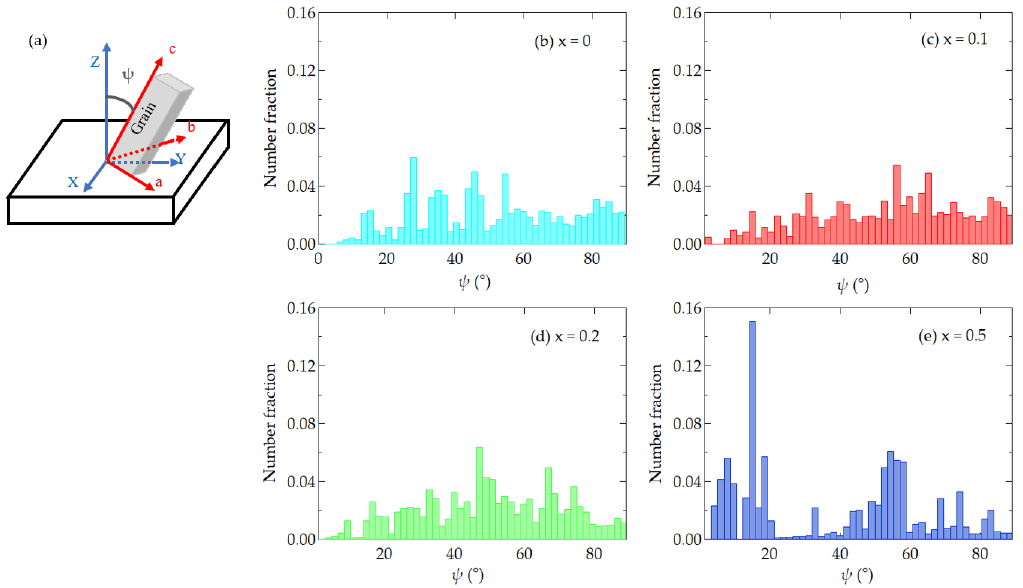
Figure 4. ( a ) Definition of angle ψ , and EDSD analyses of crystal orientation distribution represented as a function of ψ of the C x S 1–x BT layers in the FeFETs with ( b ) x = 0; ( c ) x = 0.1; ( d ) x = 0.2; and ( e ) x = 0.5. In each Figure of ( b – e ), integration of number fraction as a function of ψ makes 1.0.